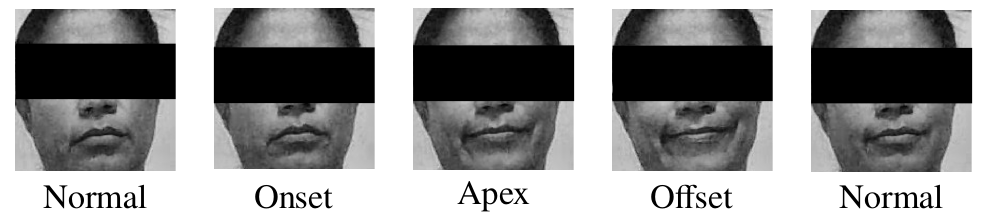
Figure 1. Sequence of frames selected for each subject.